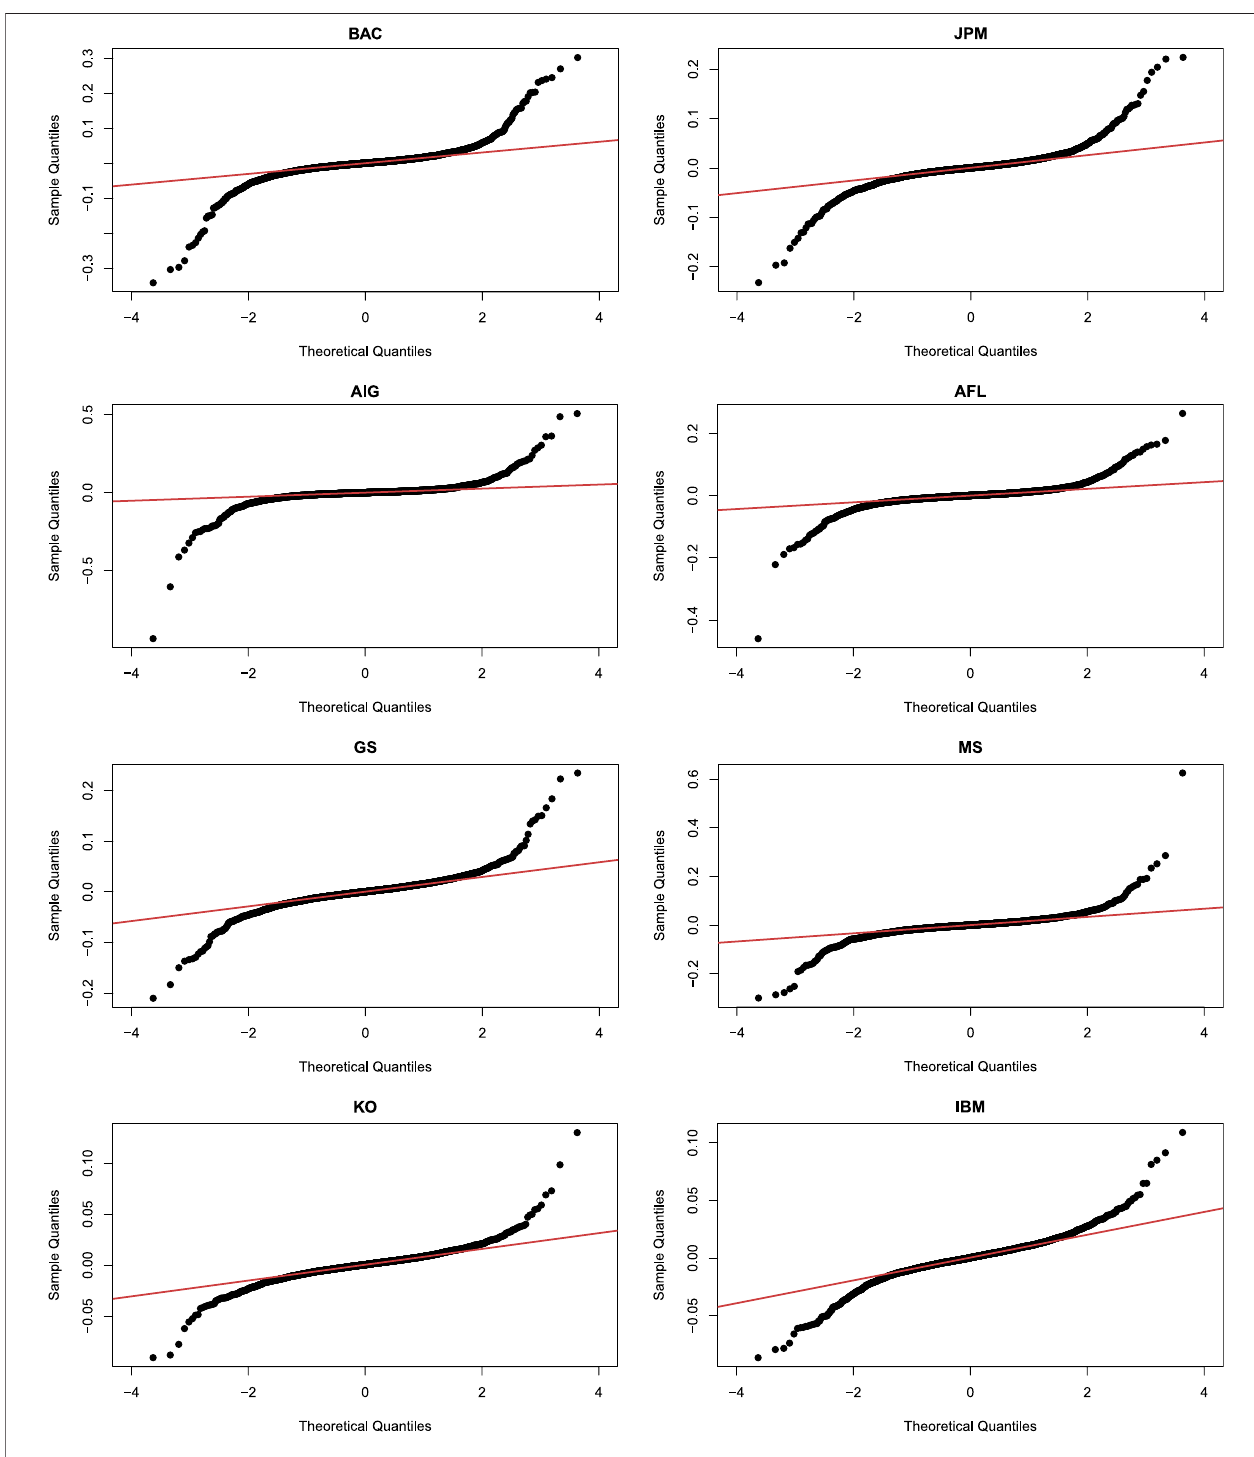
FIGURE 5 | QQ plots of the returns of BAC, JPM, AIG, AFL, GS, MS, KO, and IBM.